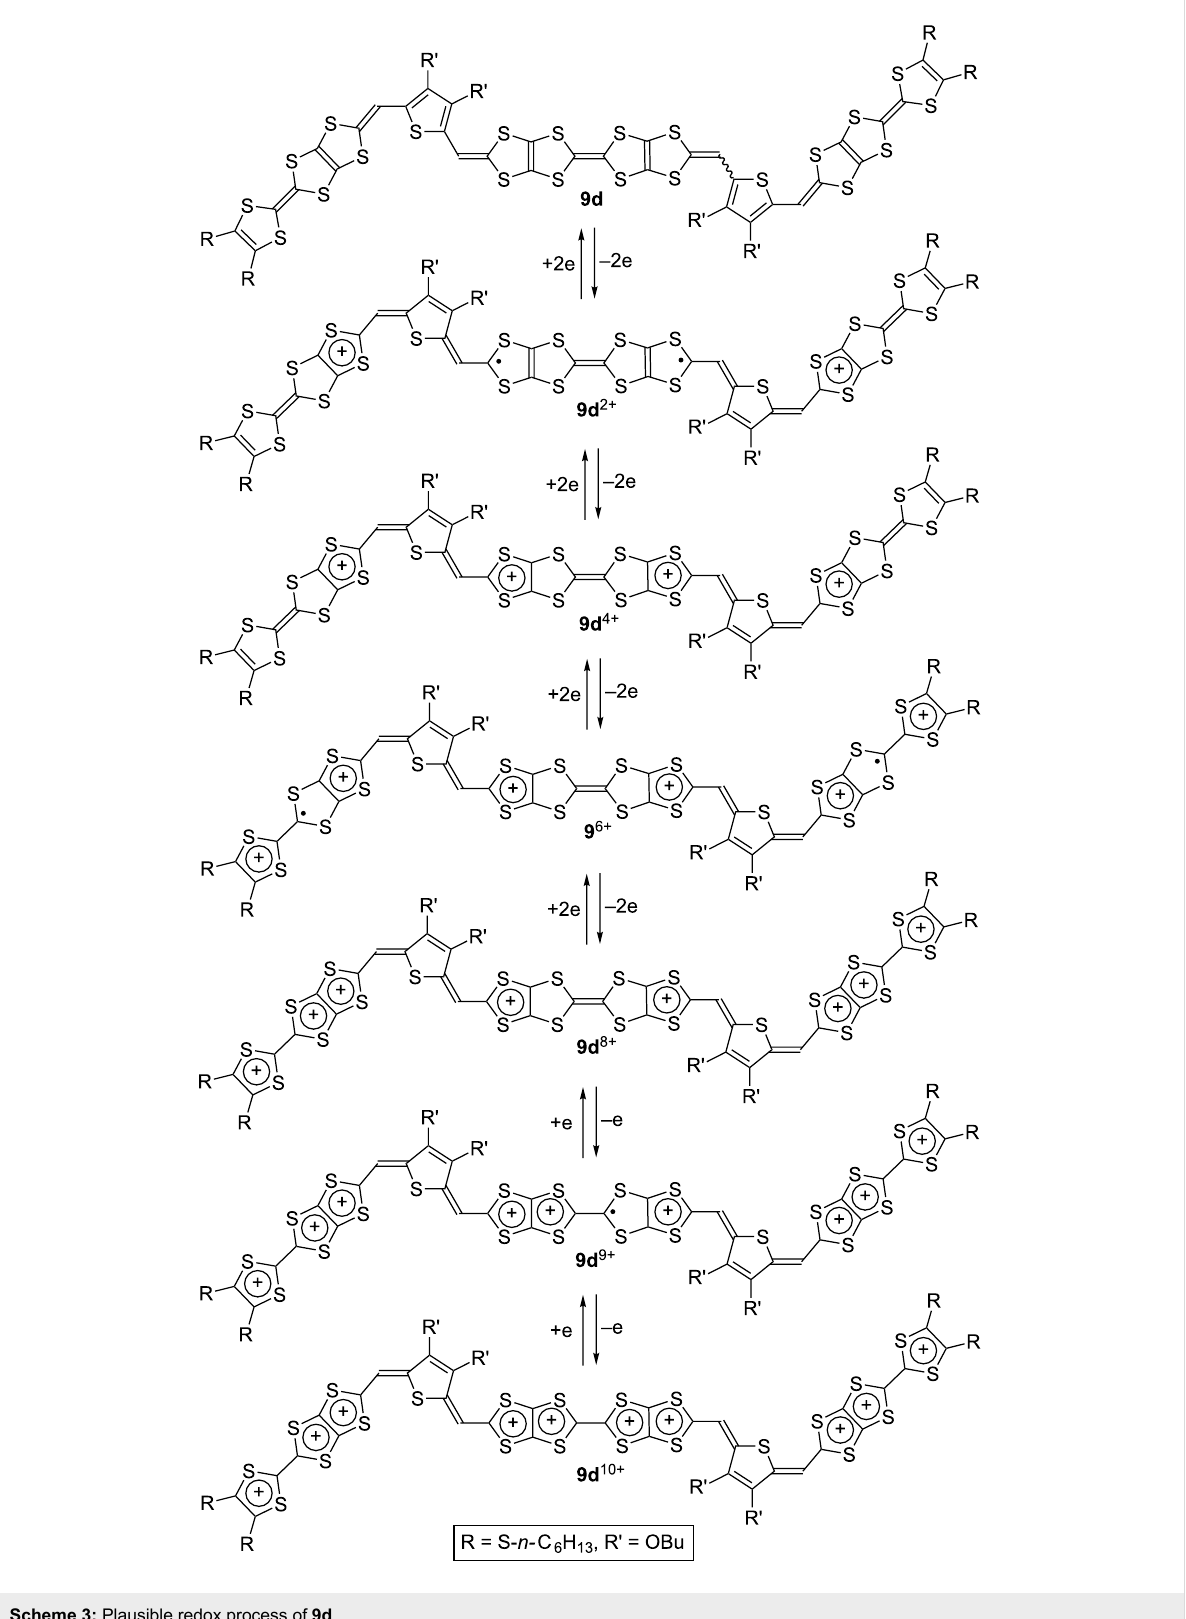
Scheme 3: Plausible redox process of 9d